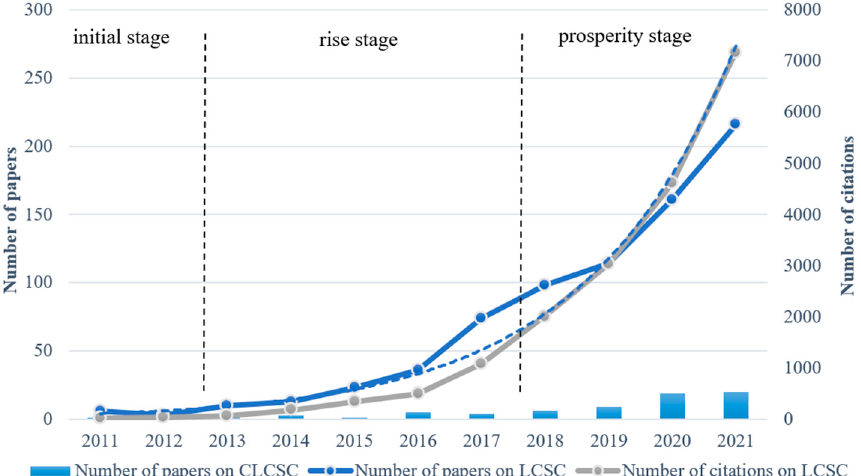
Figure 1. Trends in the quantity of articles and citations.